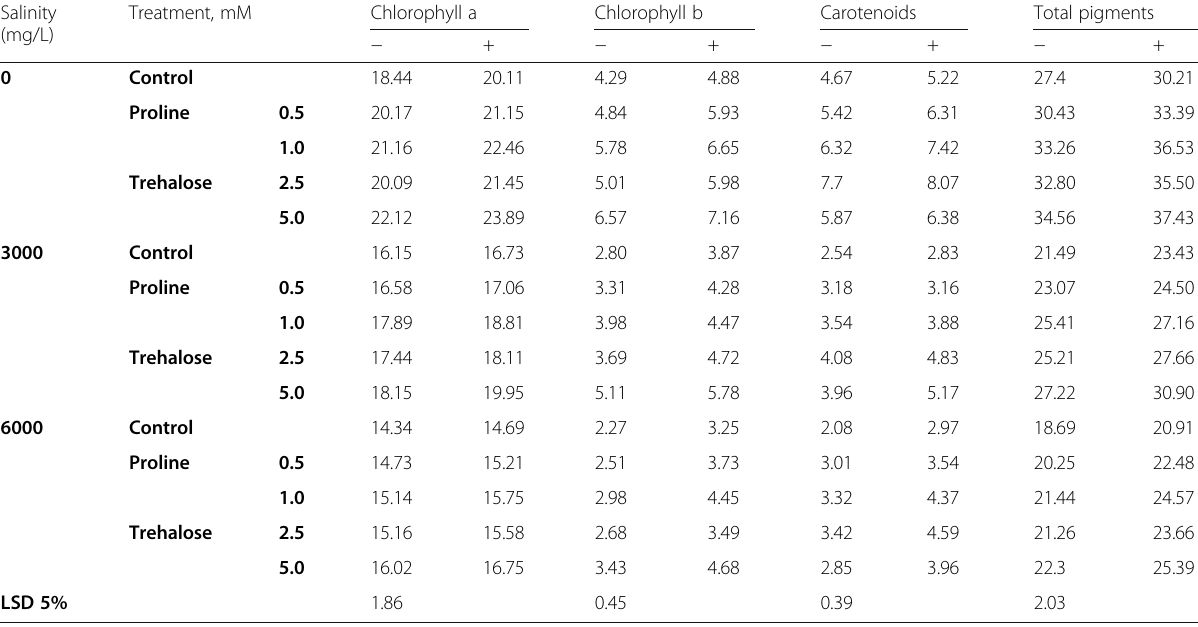
Table 4 Photosynthetic pigments ( μ g/g fresh weight) of quinoa treated with proline or trehalose with (+) and without ( − ) compost amendment under salinity stress (average of two seasons) Salinity (mg/L)